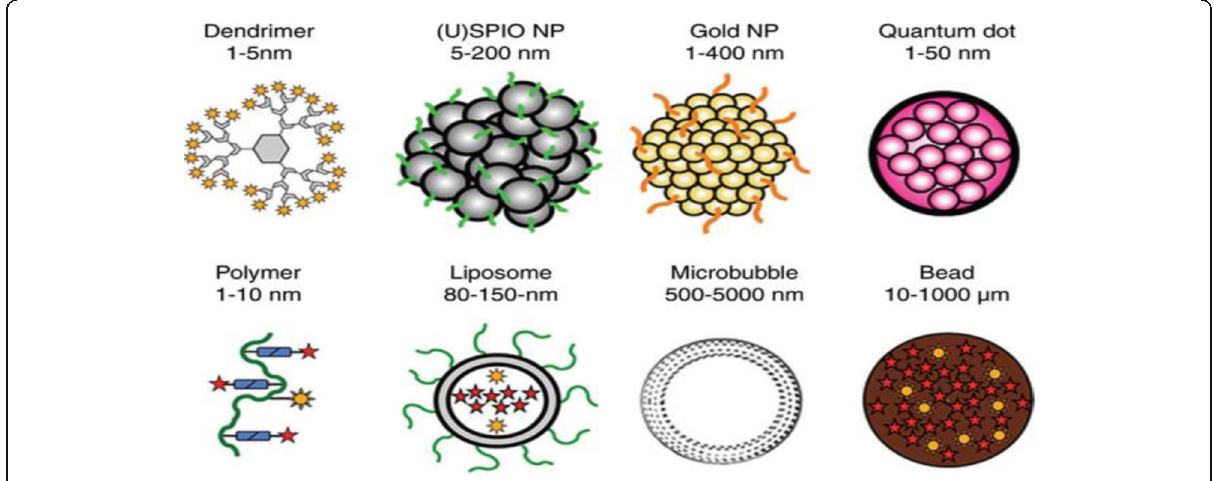
Fig. 1 Specification of some nanoparticles frequently used for diagnostic and therapeutic purposes